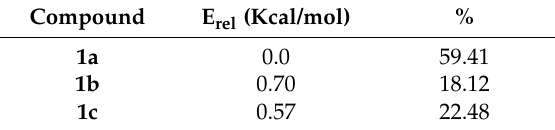
Figure 4. Rotamers for 1 . Table 1. Boltzmann population for rotamers of 1 .